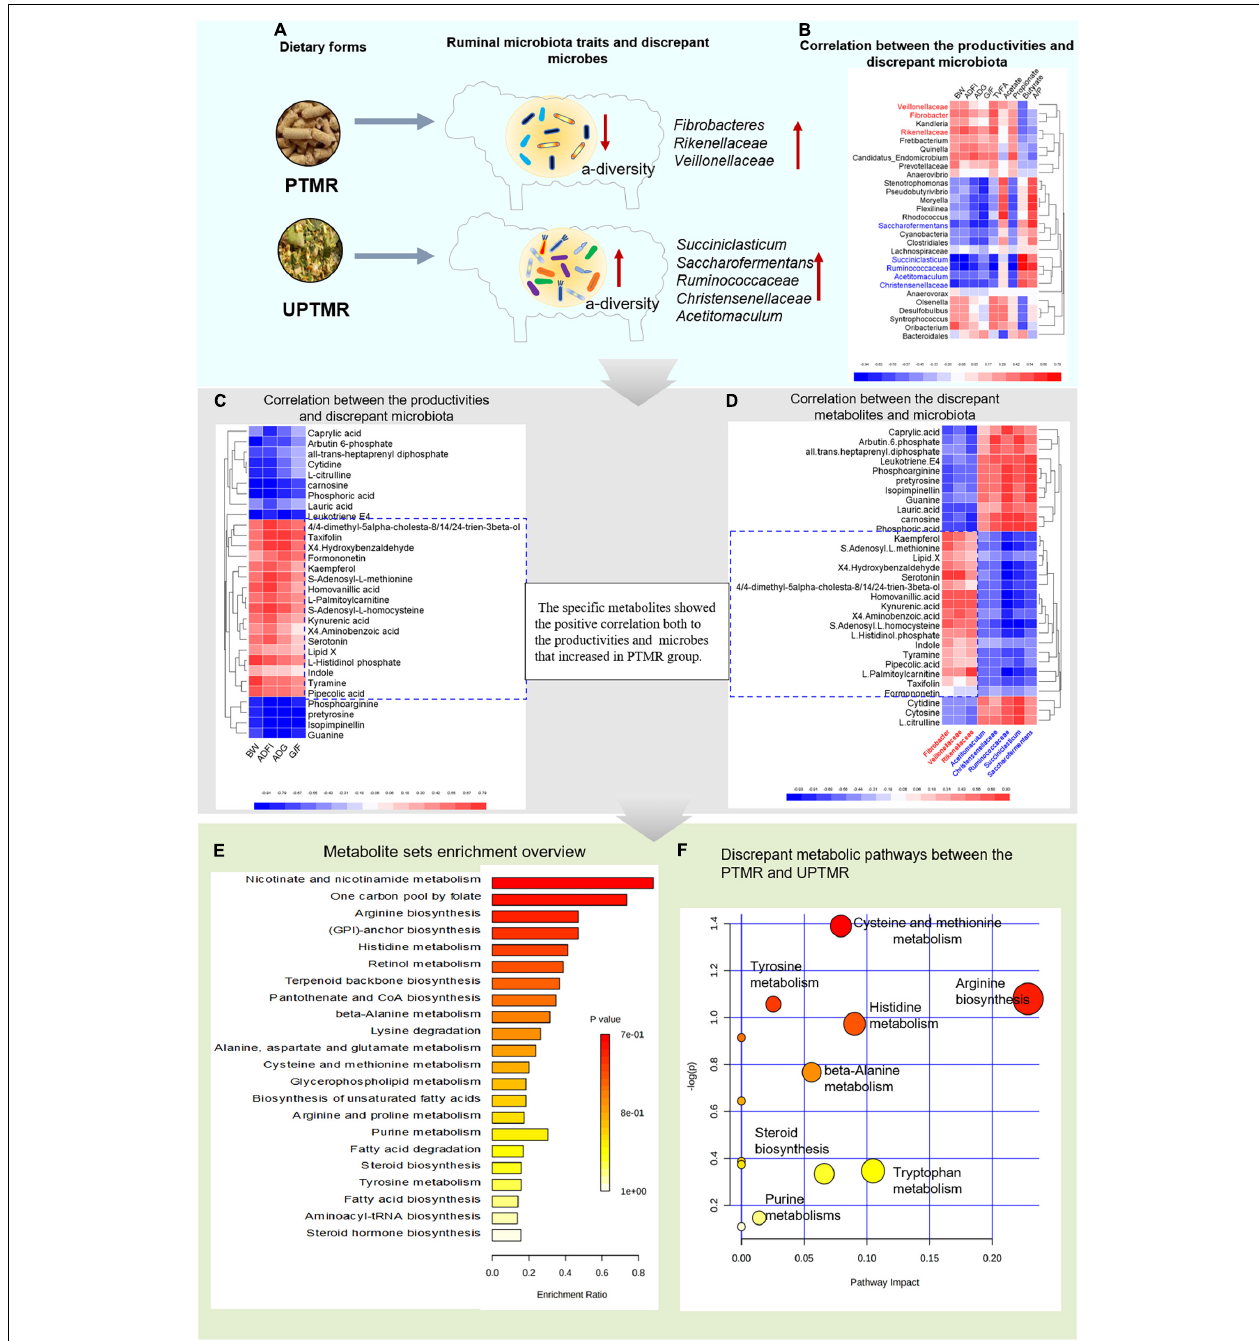
FIGURE 4 | The cause-and-effect process of dietary form affecting the performance of lambs fed PTMR or UPTMR diet. (A) The dietary form specially impacted the ruminal microbes. (B) Correlation between the production performance [body weight (BW), average daily gain (ADG), average daily feed intake (ADFI), and G/F)], volatile fatty acid (VFA) yield, and differentiated ruminal microbiota. (C) Correlation between the differentiated ruminal microbiota and metabolites. (D) Correlation between the growth performance and differential metabolites. (E) Enriched metabolic pathways based on the differentiated metabolites between the PTMR and UPTMR groups, following the library of pathway-associated metabolites sets (SMPDB). P -value showed the match status and P < 0.05 means a well matching. (F) Pathway analysis of differential metabolites. The manipulated metabolic pathways are based on the analysis of differentiated ruminal metabolites of lambs fed PTMR or UPTMR diets following the Bos taurus Kyoto Encyclopedia of Genes and Genomes (KEGG) pathway database. The metabolome view shows all the matched pathways according to the P -values from the pathway enrichment analysis and impact values from the topology analysis. The node colors varied from yellow to red, indicating that the metabolites have the data with different levels of significance. 1, arginine biosynthesis; 2, cysteine and methionine metabolism; 3, histidine metabolism; 4, tyrosine metabolism; 5, tryptophan metabolism; 6, malate–aspartate shuttle; 7, steroid biosynthesis; and 8, purine metabolism.